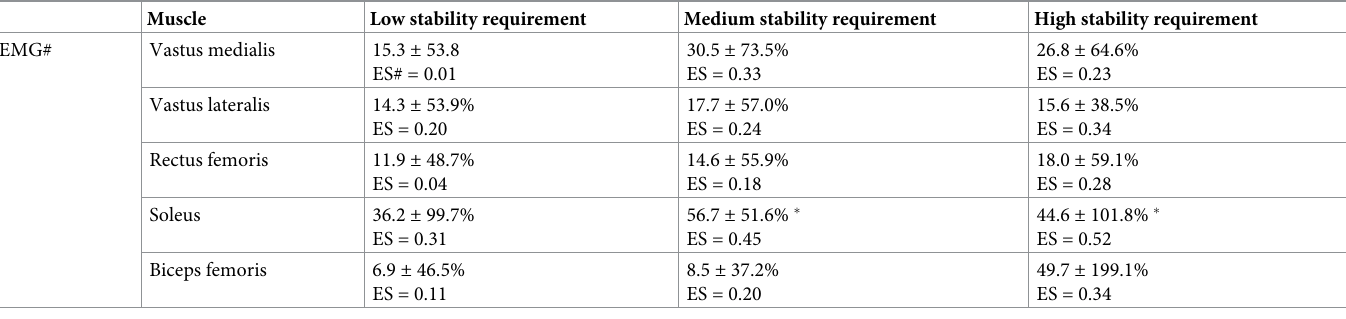
Table 3. Relative (%) changes in electromyographic (EMG) activity between pre-test and week 3 test for the different stability